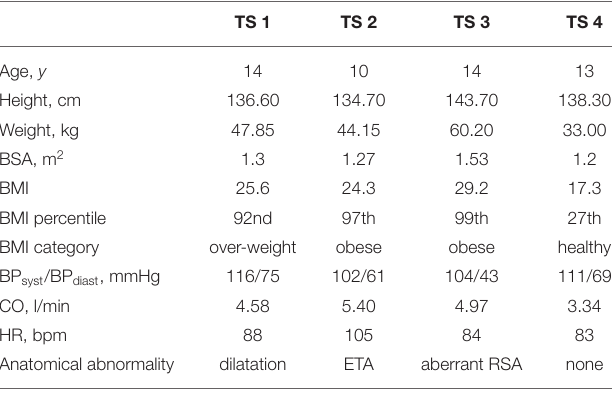
TABLE 1 | Biometric and anatomical data for the Turner syndrome (TS) girls ( n =